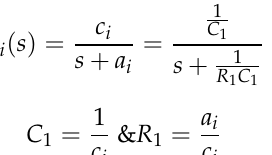
Figure 7. Proposed high frequency grounding system behavior considering soil ionization.